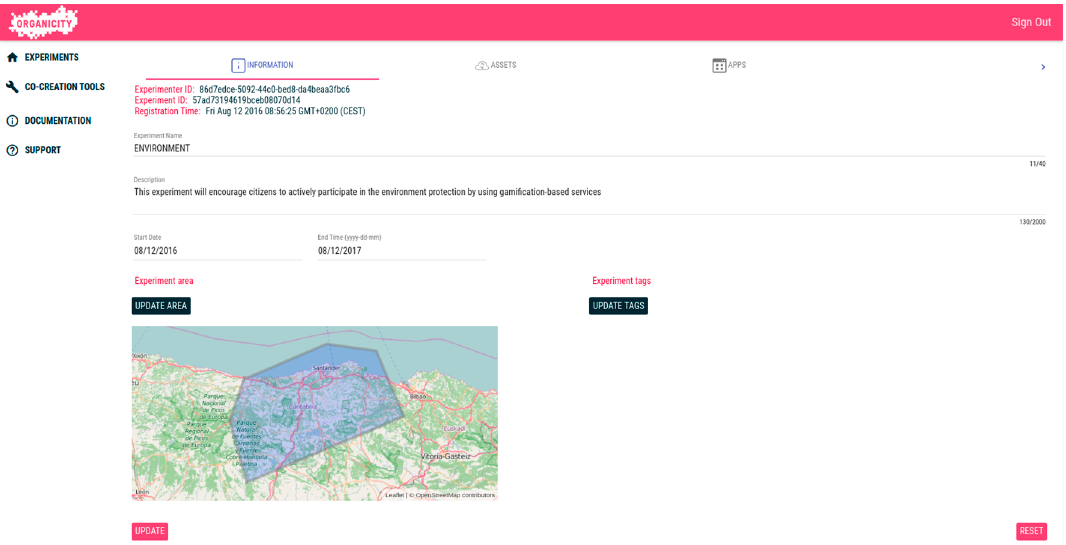
Figure 11. Opportunistic communication experiment details.